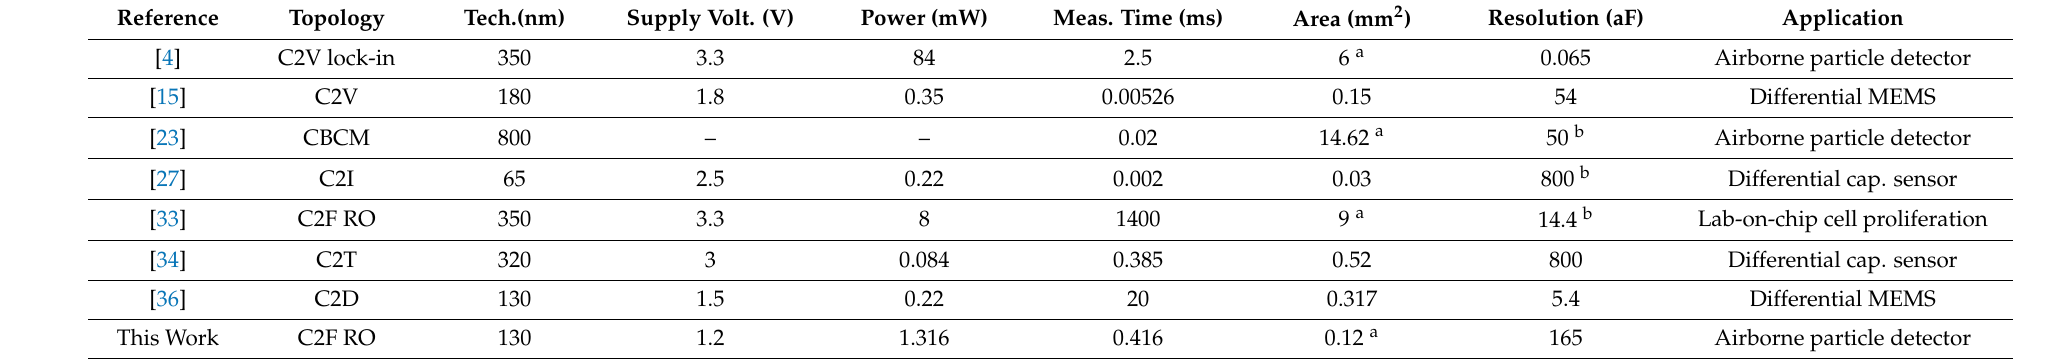
Table 4. Performance summary and comparison with the state of the